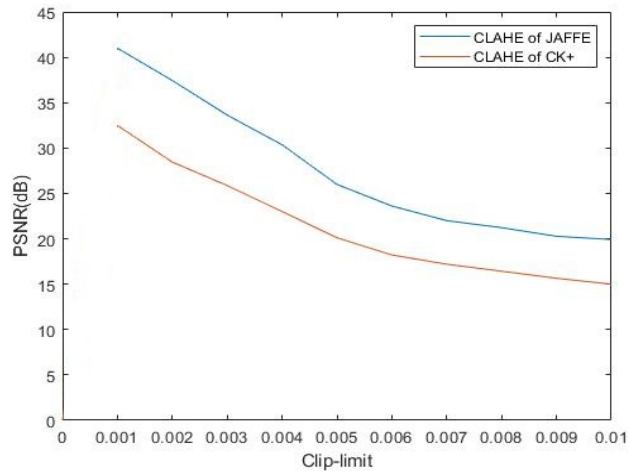
Figure 7. Peak signal to noise ratio (PSNR) values of each variation.